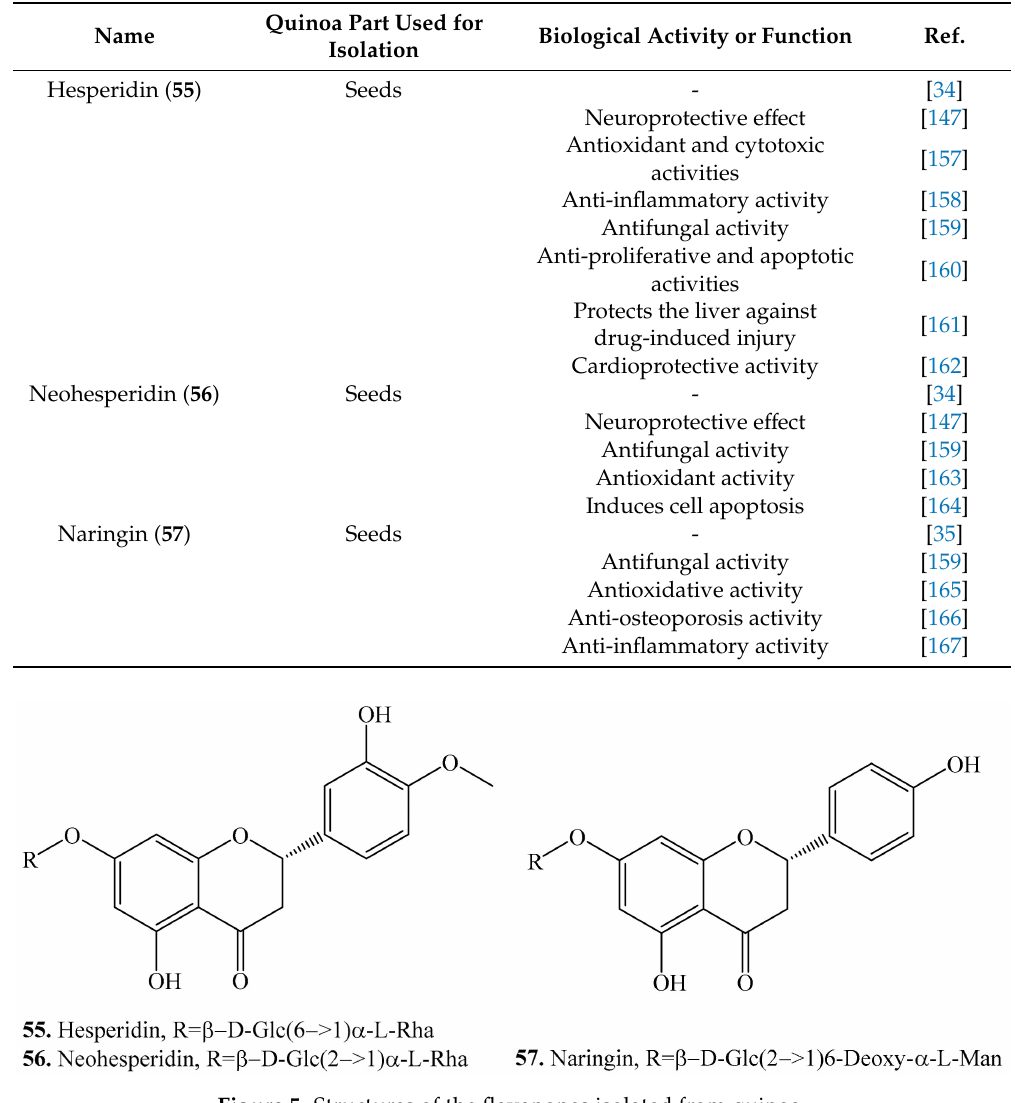
Figure 5. Structures of the flavanones isolated from